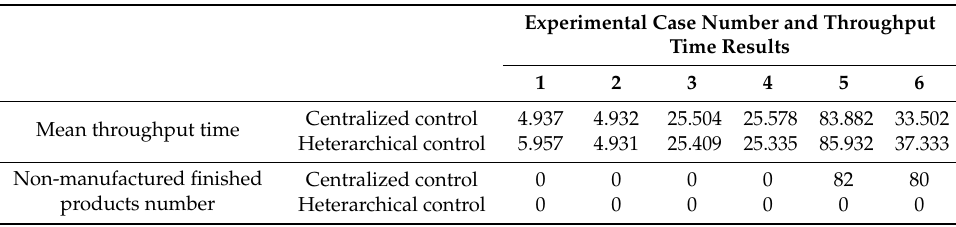
Table 5. Simulation results for the assembly station control. Throughput time expressed in